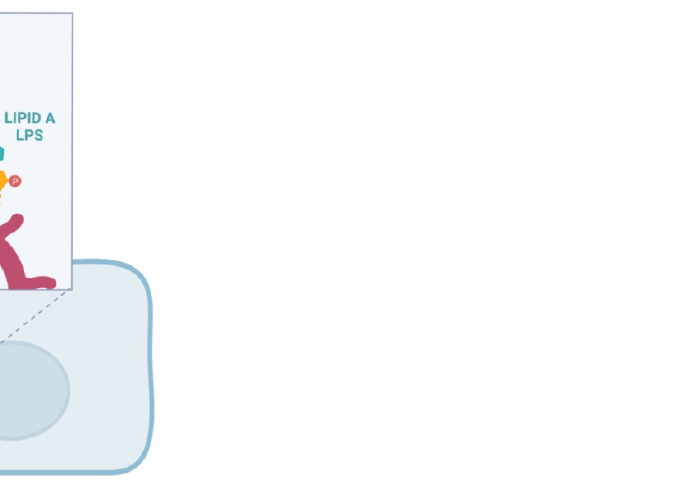
Figure 4 . The RNF213 ubiquitin (Ub) E3 ligase domain mediates the ubiquitylation of Lipid A of bacterial lipopolysaccharide (LPS).